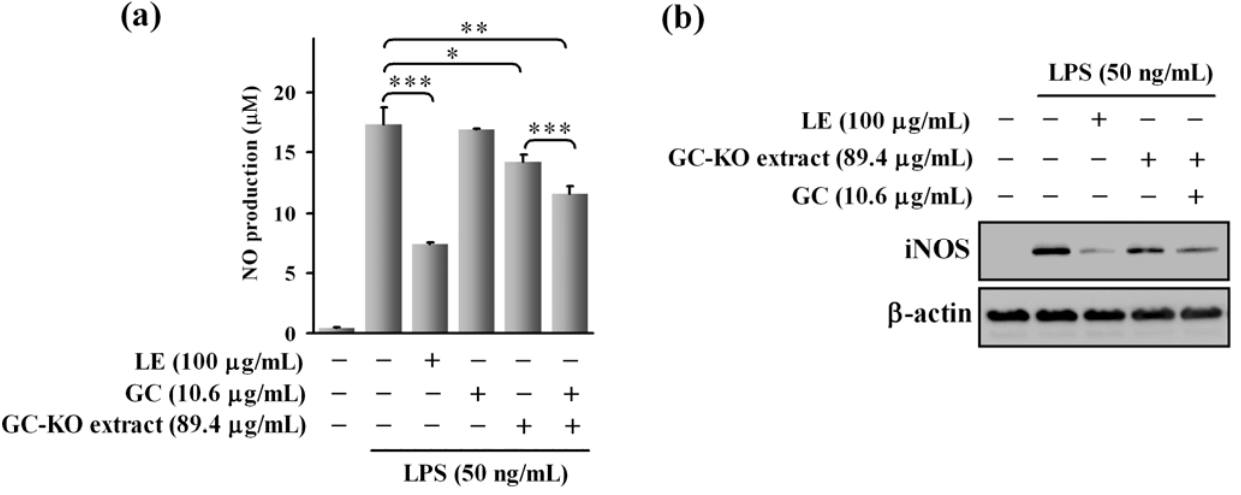
Figure 6. Comparison of the effects of the GC-KO extract and the combination of the GC-KO extract and GC on LPS-induced ( a ) NO production and ( b ) iNOS expression. Cells were treated with LE (100  g/mL), GC-KO extract (89.4  g/mL), GC (10.6  g/mL), or the combination of GC-KO extract (89.4  g/mL) and GC (10.6  g/mL). * p < 0.05, ** p < 0.01, and *** p < 0.001 indicate significant differences from the effects of LPS